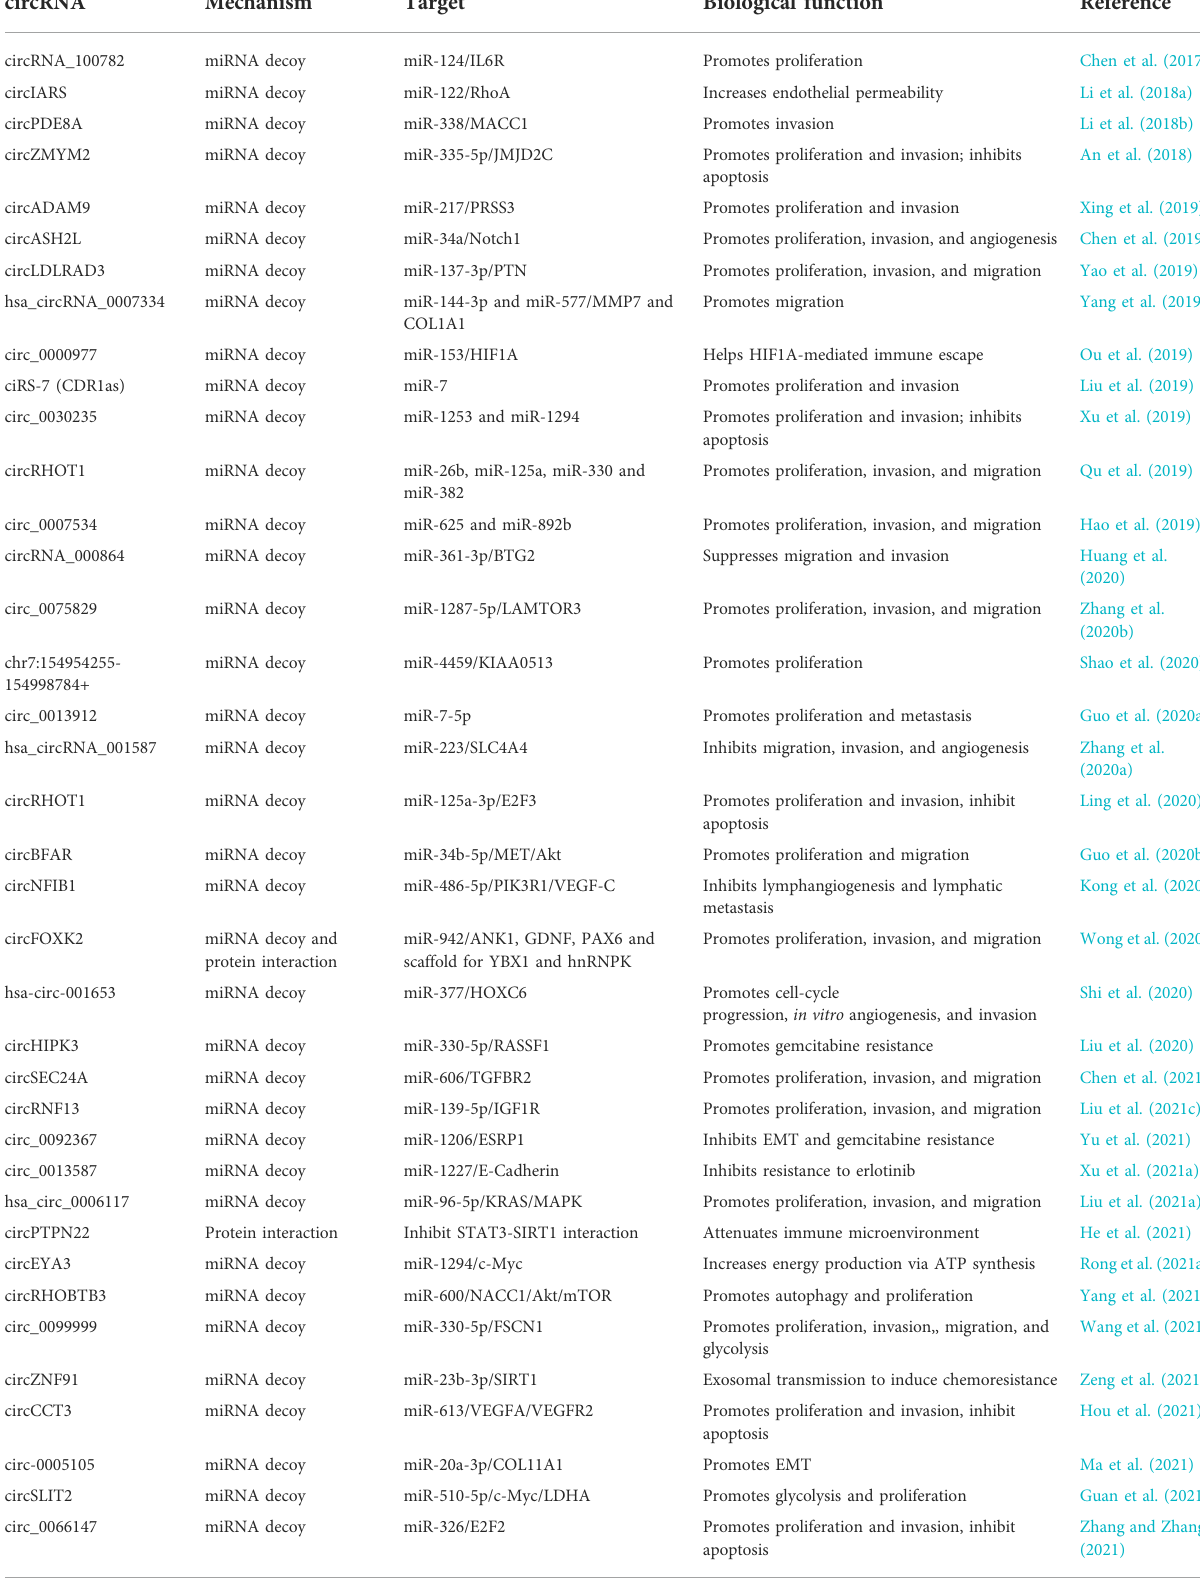
TABLE 1 Pathogenic circRNAs in pancreatic